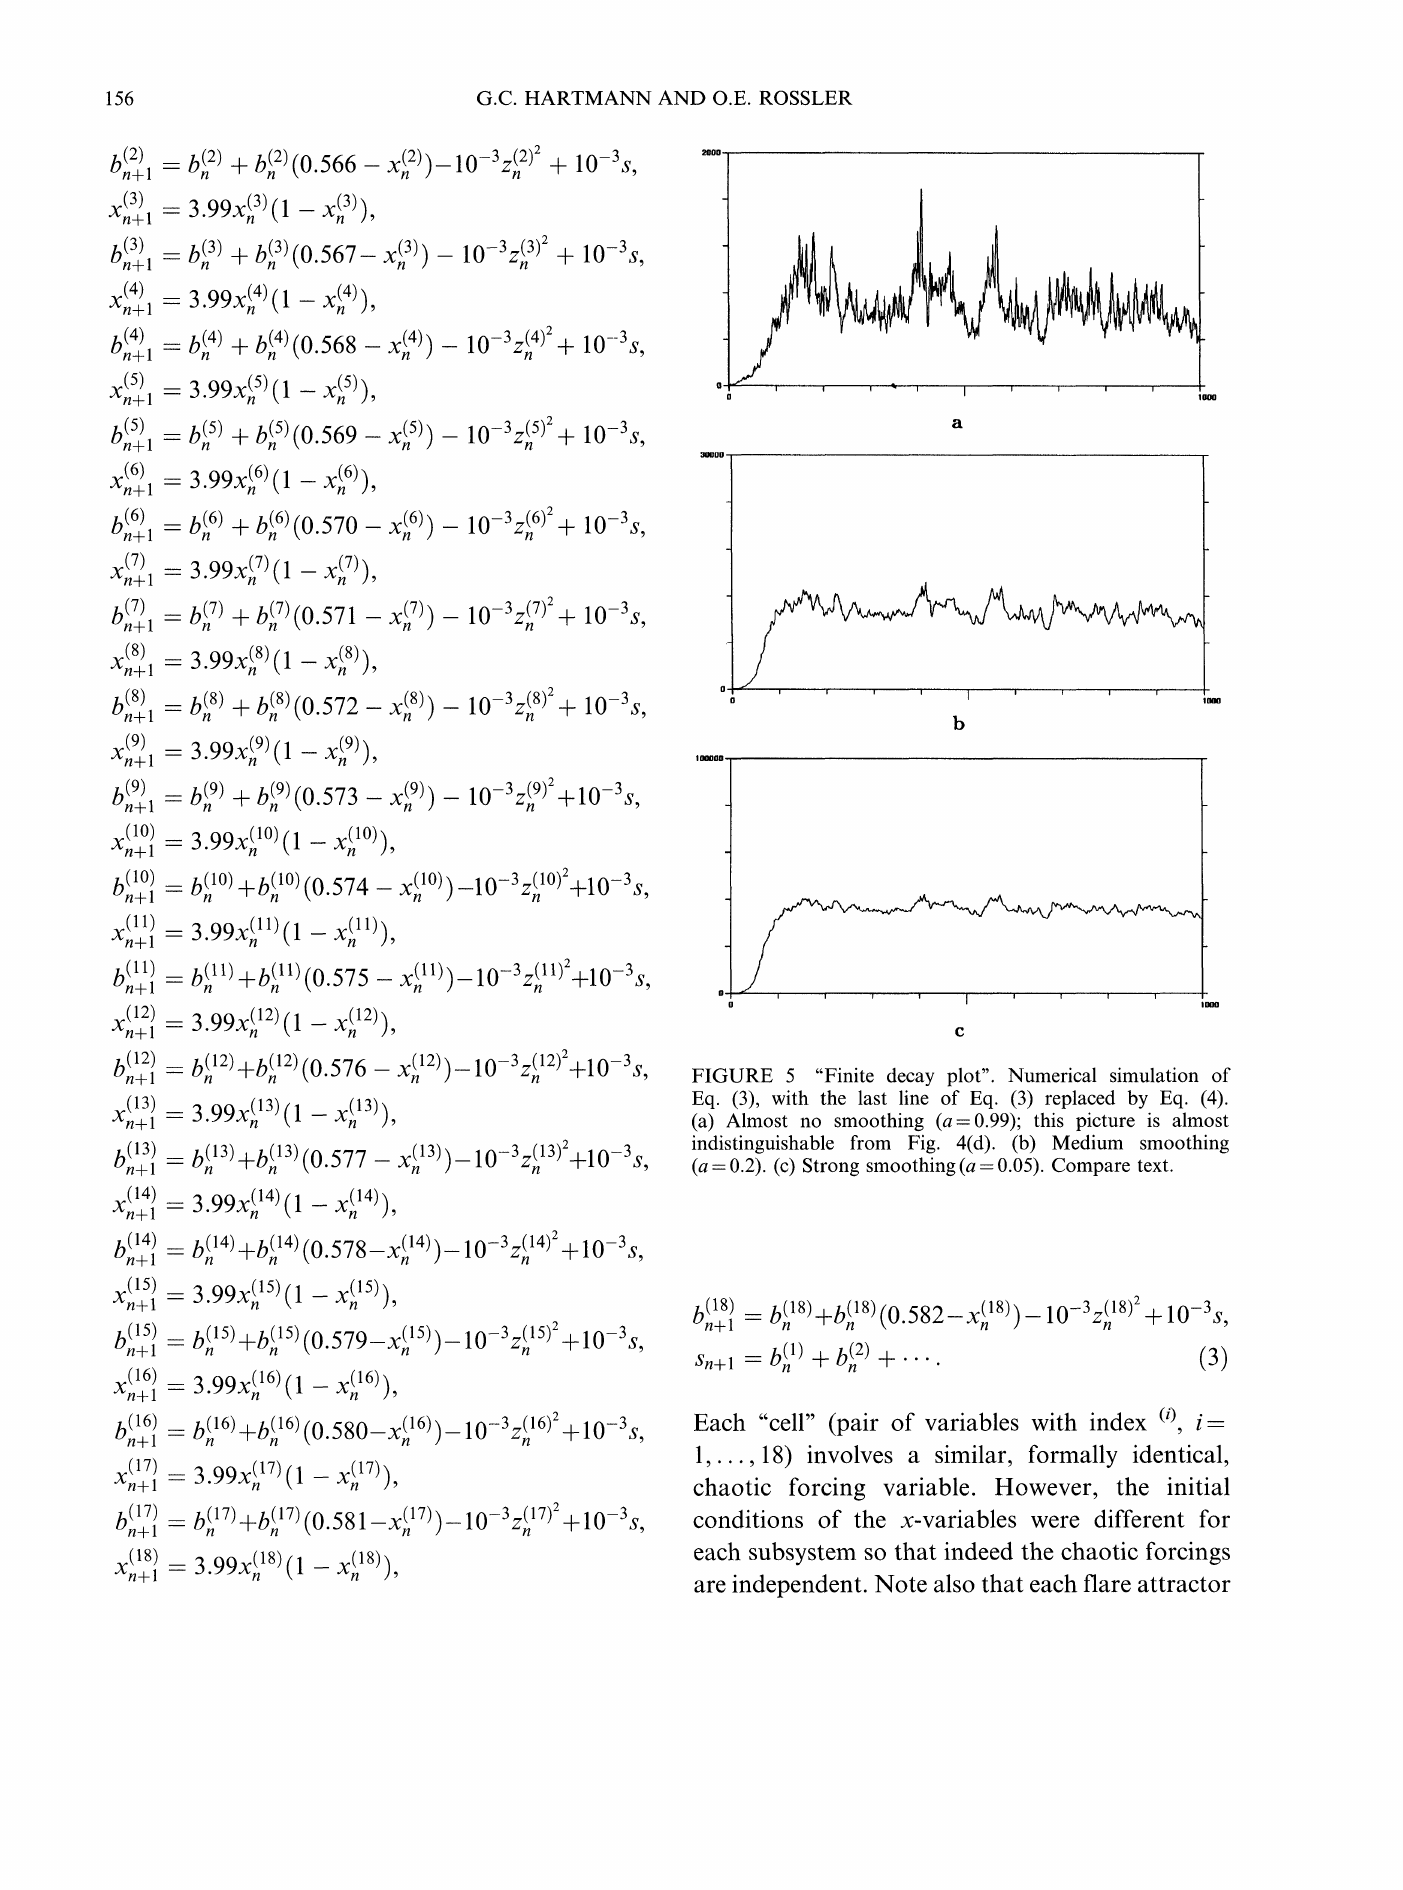
Each "cell" (pair of variables with index (i), i- 1,..., 18) involves a similar, formally identical, chaotic forcing variable. However, the initial conditions of the x-variables were different for each subsystem so that indeed the chaotic forcings are independent. Note also that each flare